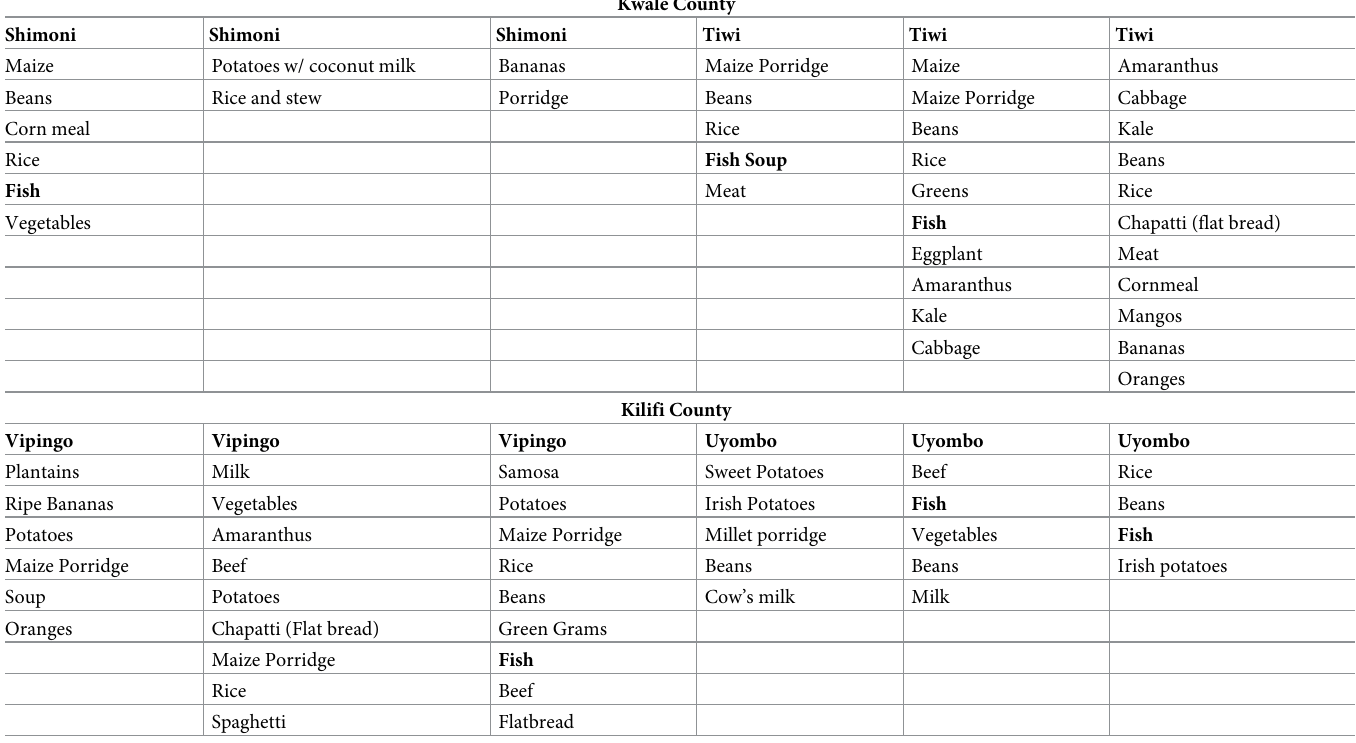
Table 4. Free list of foods identified as part of a healthy diet for young